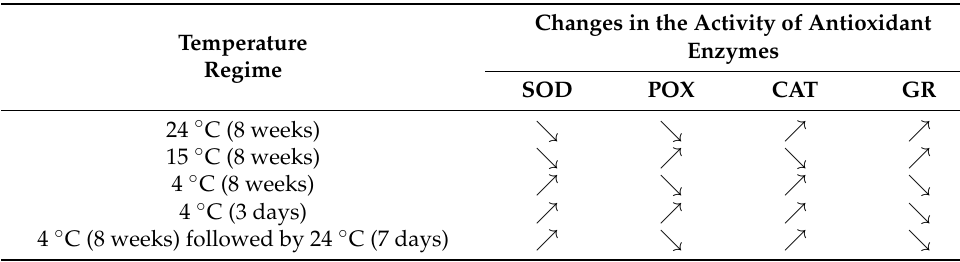
Table 4. Effect of temperature regime on activity of antioxidant enzymes assayed in F. meleagris bulbs in vitro